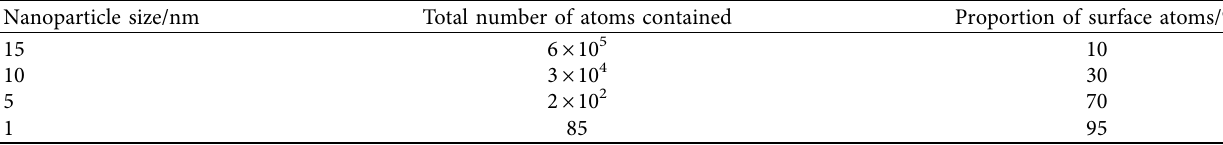
Table 3: Surface and interface effects of nanomaterial particles.